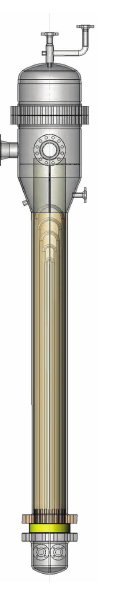
Figure 5: PWR PACTEL steam generator.